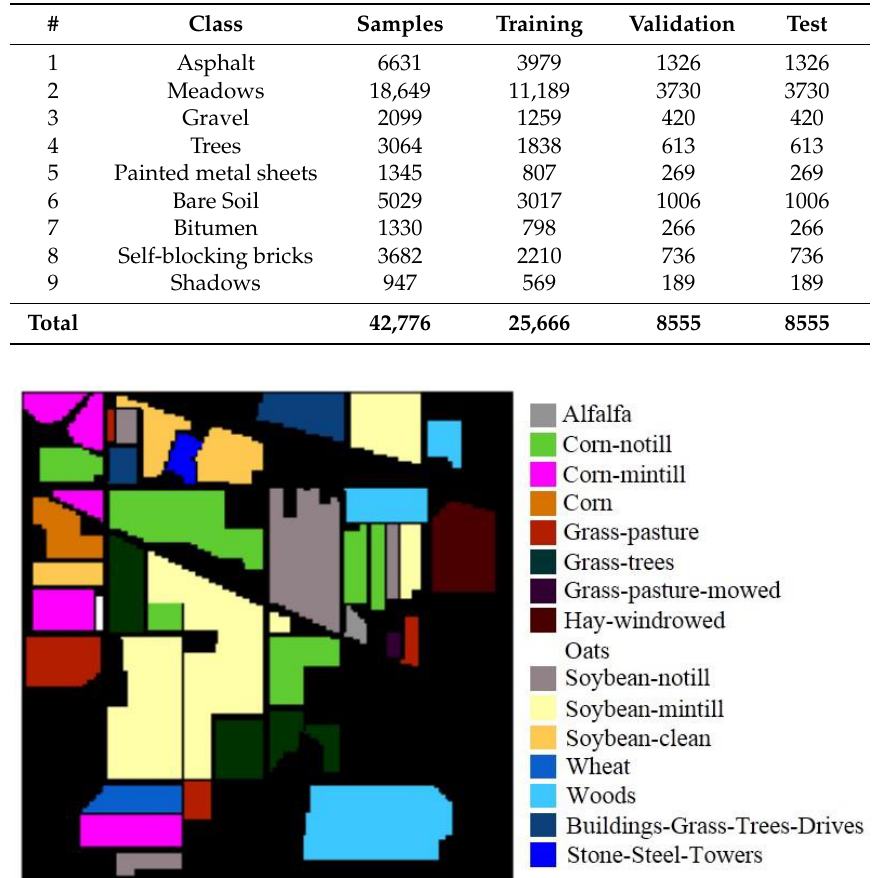
Figure 3. Pavia University representing nine classes. Table 1. Land cover classes and numbers in Pavia University.